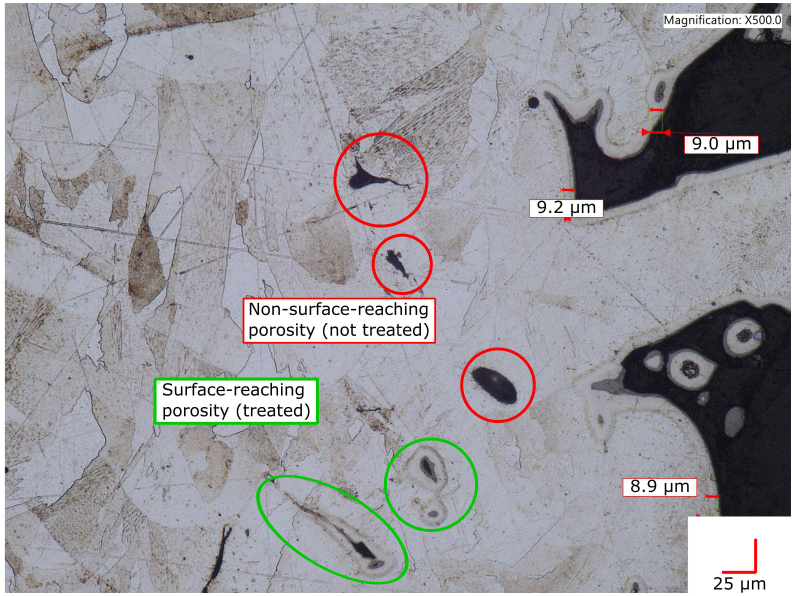
Figure 6. Cross-sectional image of an LTNC-SRP-treated AM Alloy 22 cup sample. The inner surface of external-surface-reaching voids exhibits a conformal, fully developed subsurface zone of interstitial solute.